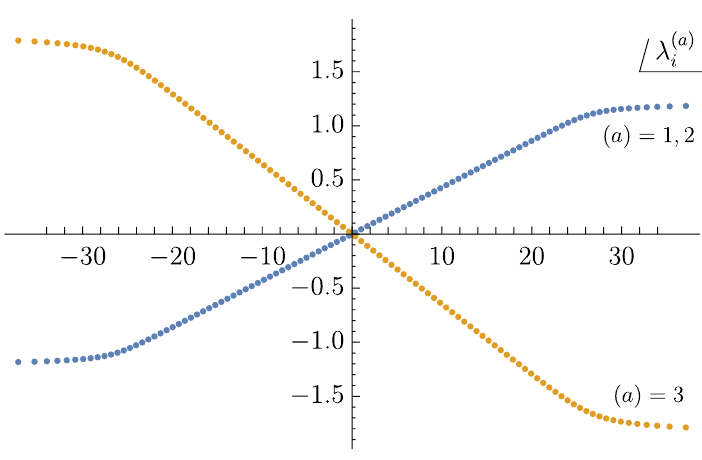
Figure 2 . The numerical solution to the saddle point equations for N = 100 and k a = (1 , 1 , − 2) . The first two sets of eigenvalues, λ (1)